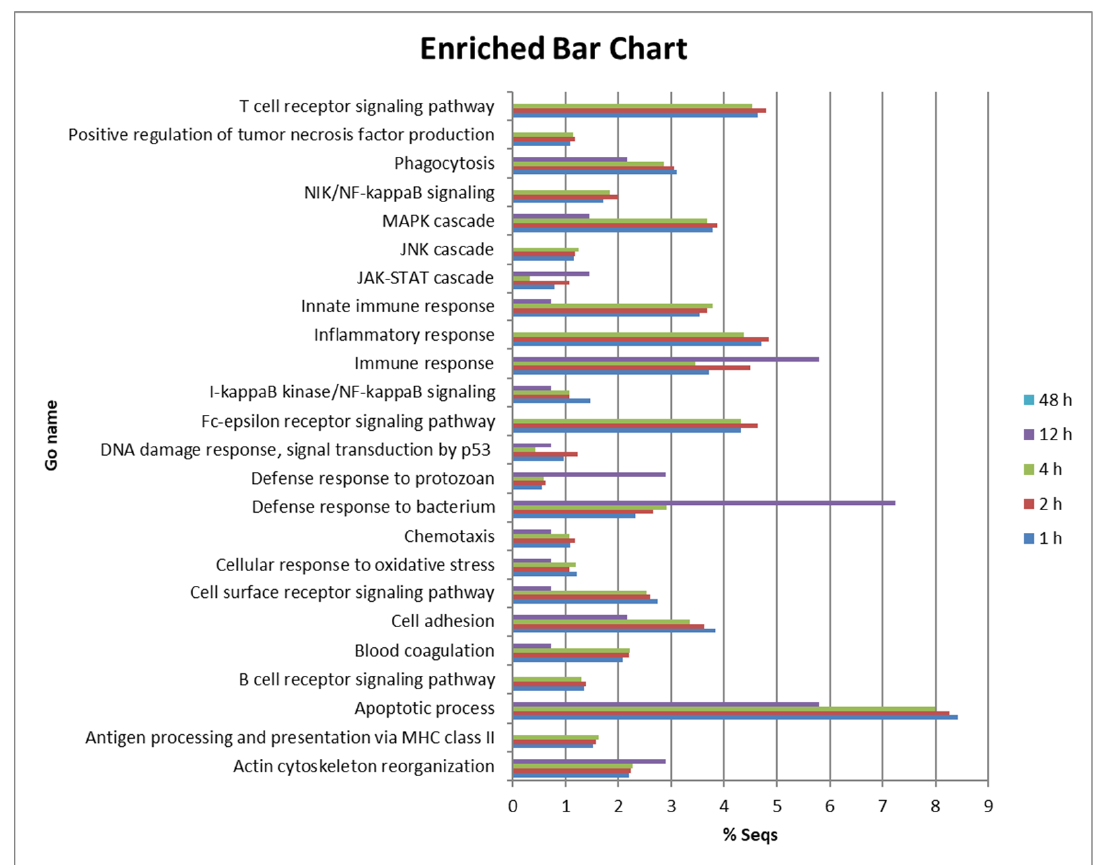
Figure 2. Bar chart showing the proportion (%) of DE genes involved in various biological processes in turbot peritoneal cells at 1, 2 and 4 hpi. Table 3. Heat map showing a group of DE genes in turbot peritoneal cells at 1, 2, 4 and 12 hpi , including genes coding for toll-like receptors and genes involved in different signalling pathways. Results are expressed as mean expression ratios of groups 1, 2 and 4 hpi vs. 0 h, or 12 hpi vs. phosphate-buffered saline (PBS). There were no DE genes at 48 hpi. Red indicates increased gene expression levels; green indicates decreased levels.